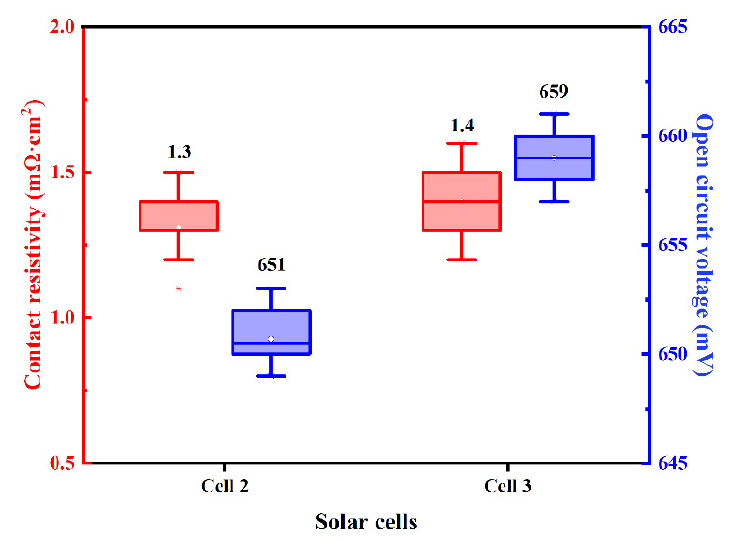
Figure 10. The distribution of the ρ c and V OC of the solar cells using the firing-through Al paste without and with Si particles.